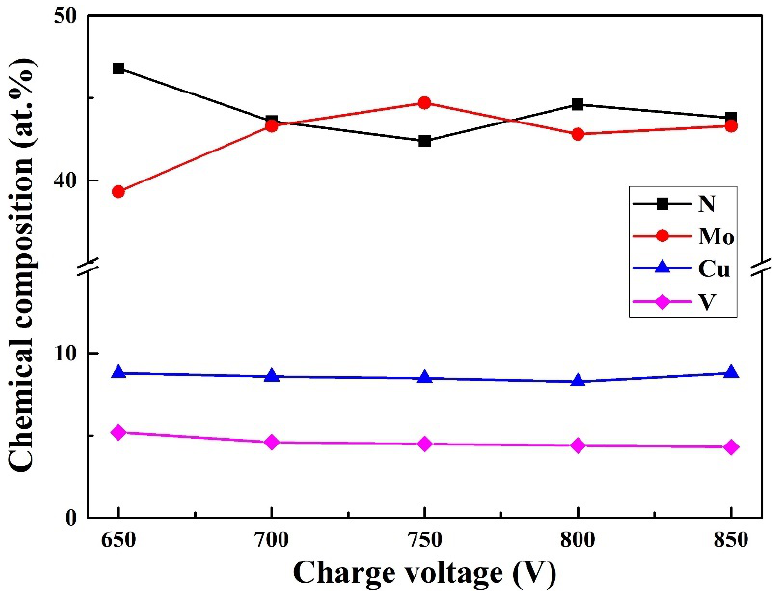
Figure 1. Chemical composition of Mo–Cu–V–N coatings as a function of charge voltage.